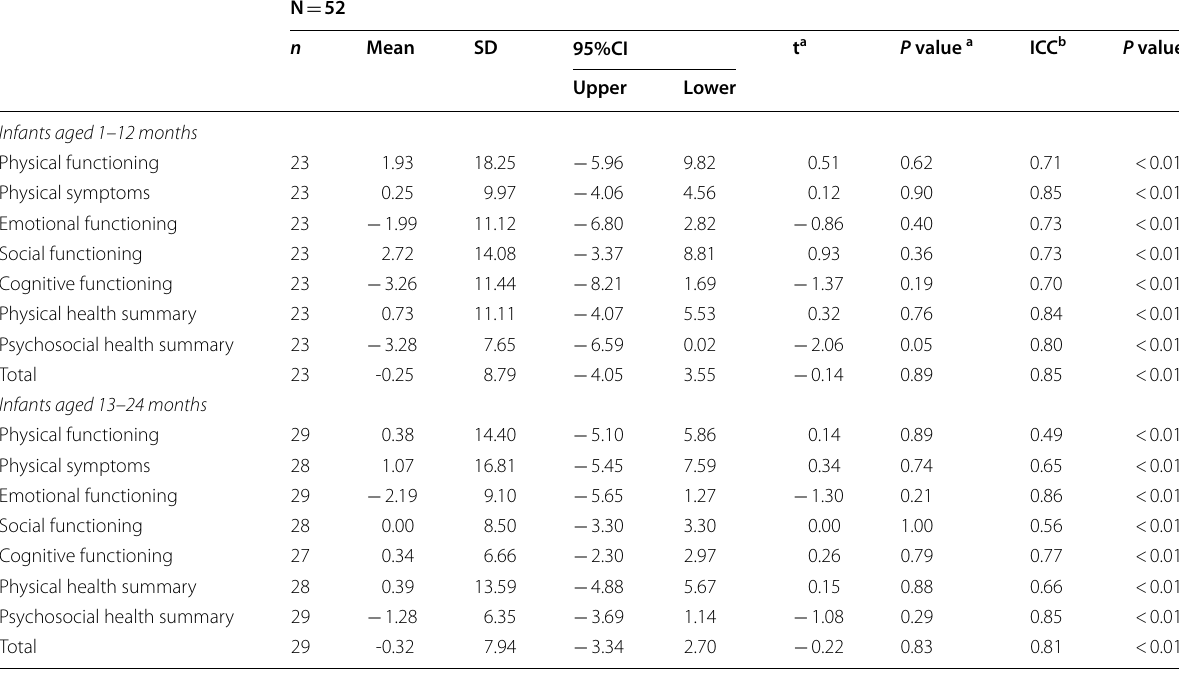
Table 4 Test–retest reliability of the Japanese version of the PedsQL Infant Scales